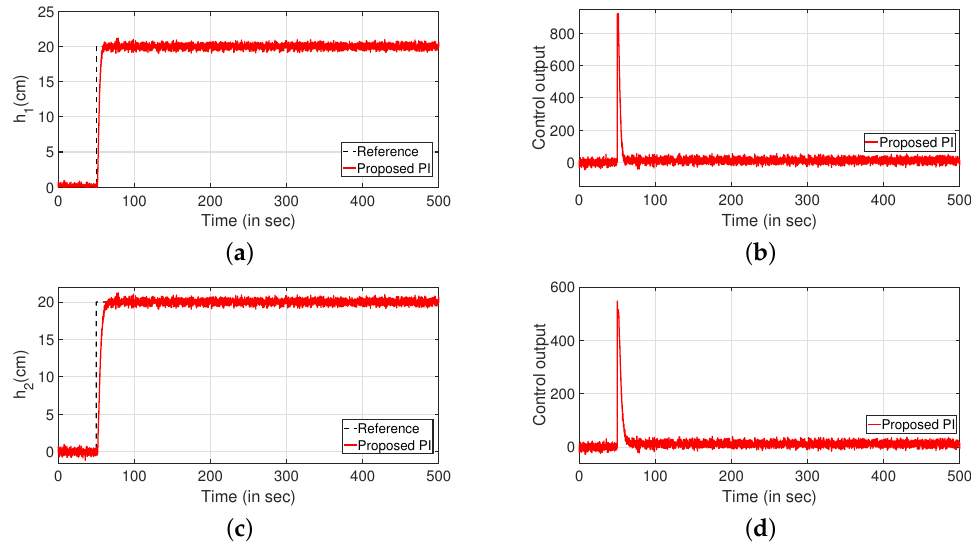
Figure 9. Reference tracking of PI controller with input uncertainties. ( a ) Level Variation in tank 1. ( b ) Control output. ( c ) Level Variation in tank 2. ( d ) Control